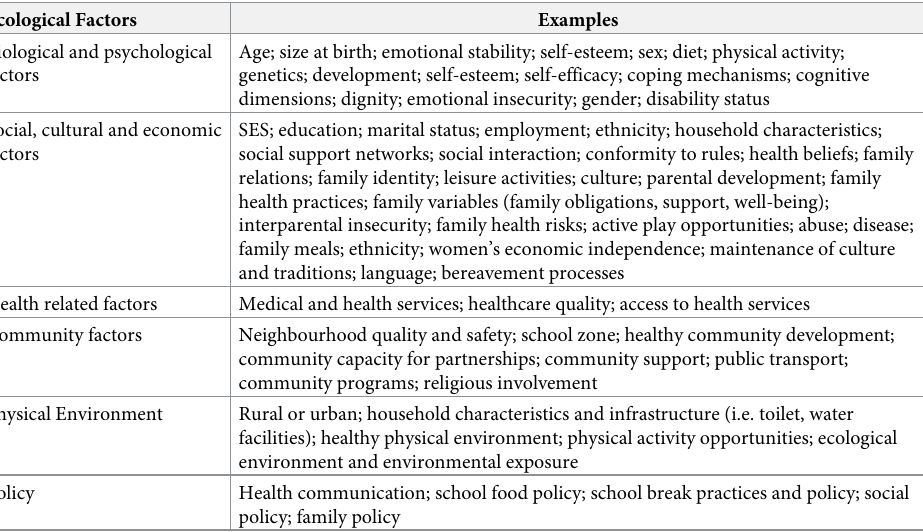
Table 4. Examples of environmental and/or ecological factors described in the